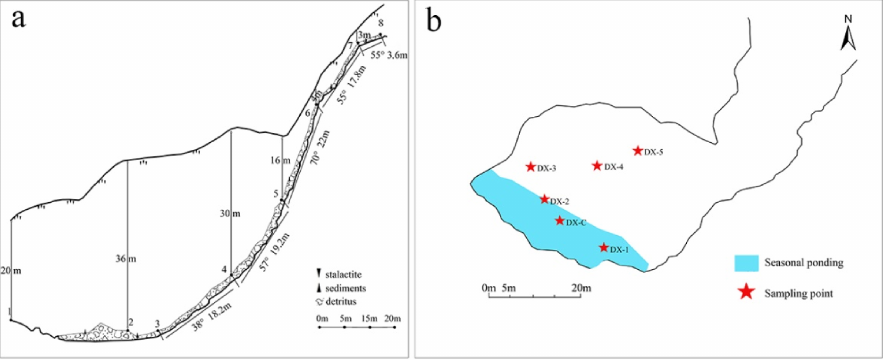
Figure 2. Schematic diagram of the profile and plane sampling points of Daxiao Cave (( a ) profile; ( b ) plane and sampling point